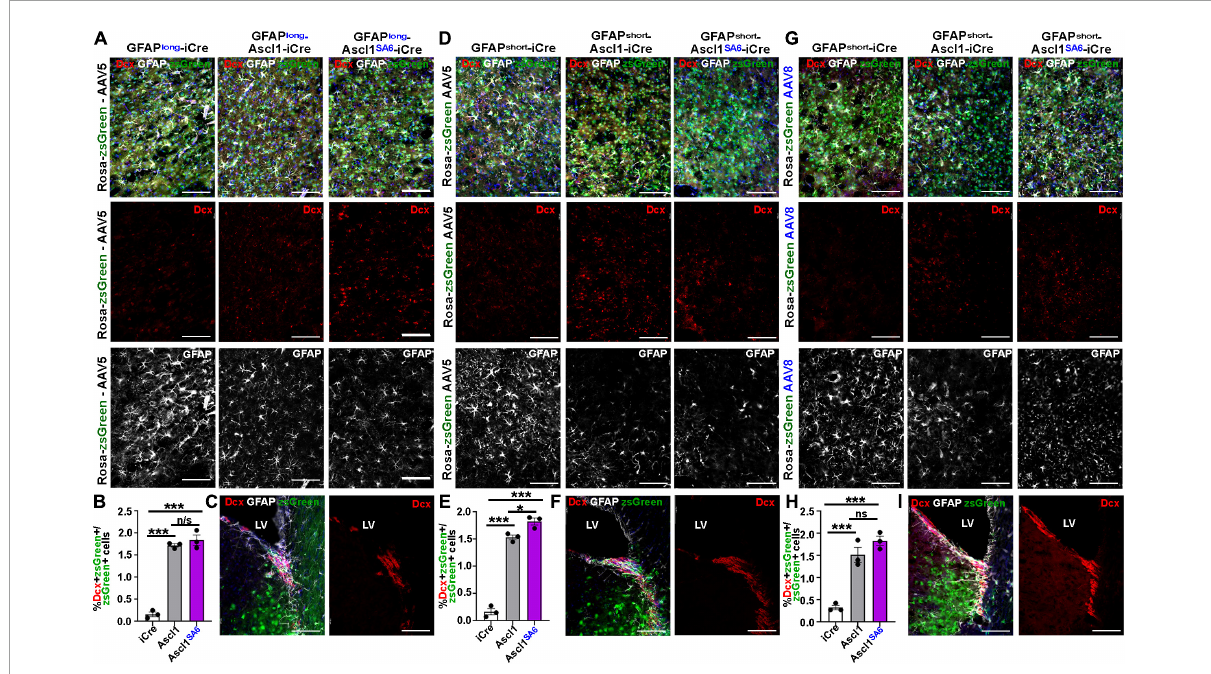
FIGURE6 Limited induction of Dcx expression in GFAP + transduced astrocytes by Ascl1 and Ascl1 SA 6 . (A–C) Rosa-zsGreen cortex transduced with AAV5-GFAPlong-iCre, AAV5-GFAPlong-Ascl1-t2a-iCre, and AAV5-GFAPlong-Ascl1 SA 6 -t2a-iCre at 21 days post-transduction, showing zsGreen epifluorescence, Dcx (red) and GFAP (white) expression in the parenchyma of the motor cortex (A) or in the ventricular-subventricular zone (V-SVZ) (C) . Blue is DAPI counterstain. (B) Quantification of the percentage of zsGreen + cells that co-express Dcx. (D–F) Rosa-zsGreen cortex transduced with AAV5-GFAPshort-iCre, AAV5-GFAPshort-Ascl1-t2a-iCre, and AAV5-GFAPshort-Ascl1 SA 6 -t2a-iCre at 21 days post-transduction, showing zsGreen epifluorescence, Dcx (red) and GFAP (white) expression in the parenchyma of the motor cortex (D) or in the ventricular-subventricular zone (V-SVZ) (F) . Blue is DAPI counterstain. Quantification of the percentage of zsGreen + cells that co-express Dcx (E) . (G–I) Rosa-zsGreen cortex transduced with AAV8-GFAPshort-iCre, AAV8-GFAPshort-Ascl1-t2a-iCre, and AAV8-GFAPshort-Ascl1 SA 6 -t2a-iCre at 21 days post-transduction, showing zsGreen epifluorescence, Dcx (red) and GFAP (white) expression in the parenchyma of the motor cortex (G) or in the ventricular-subventricular zone (V-SVZ) (I) . Blue is DAPI counterstain. Quantification of the percentage of zsGreen + cells that co-express Dcx (H) . Scale bars = 100 µ m. LV, lateral ventricle. Significance was defined as p -values less than 0.05 and denoted as follows: ns, not significant, < 0.05 *, < 0.01 **, < 0.001